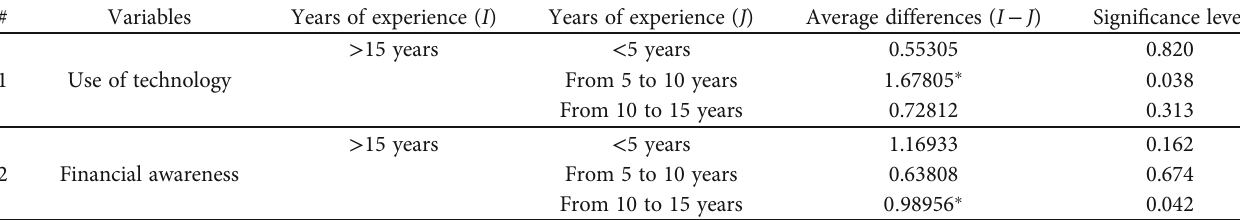
T ABLE 10: Dimensional comparisons using Scheffe ’ s